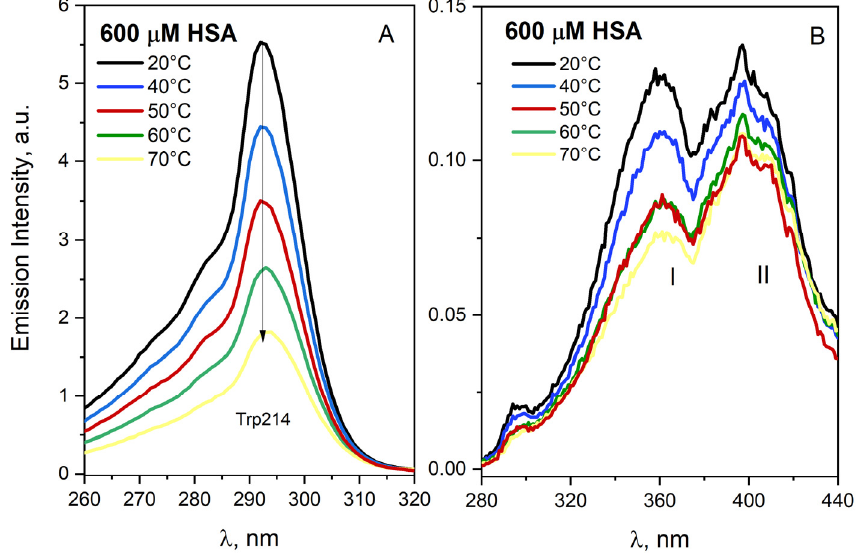
Figure 5. ( A ). Emission excitation spectra of the neat HSA solution (600 µM). The emission wavelength was 345 nm. ( B ). Emission excitation spectra of the HSA aggregates (600 µM). The emission wavelength was 500 nm. I and II—number of excitation bands.